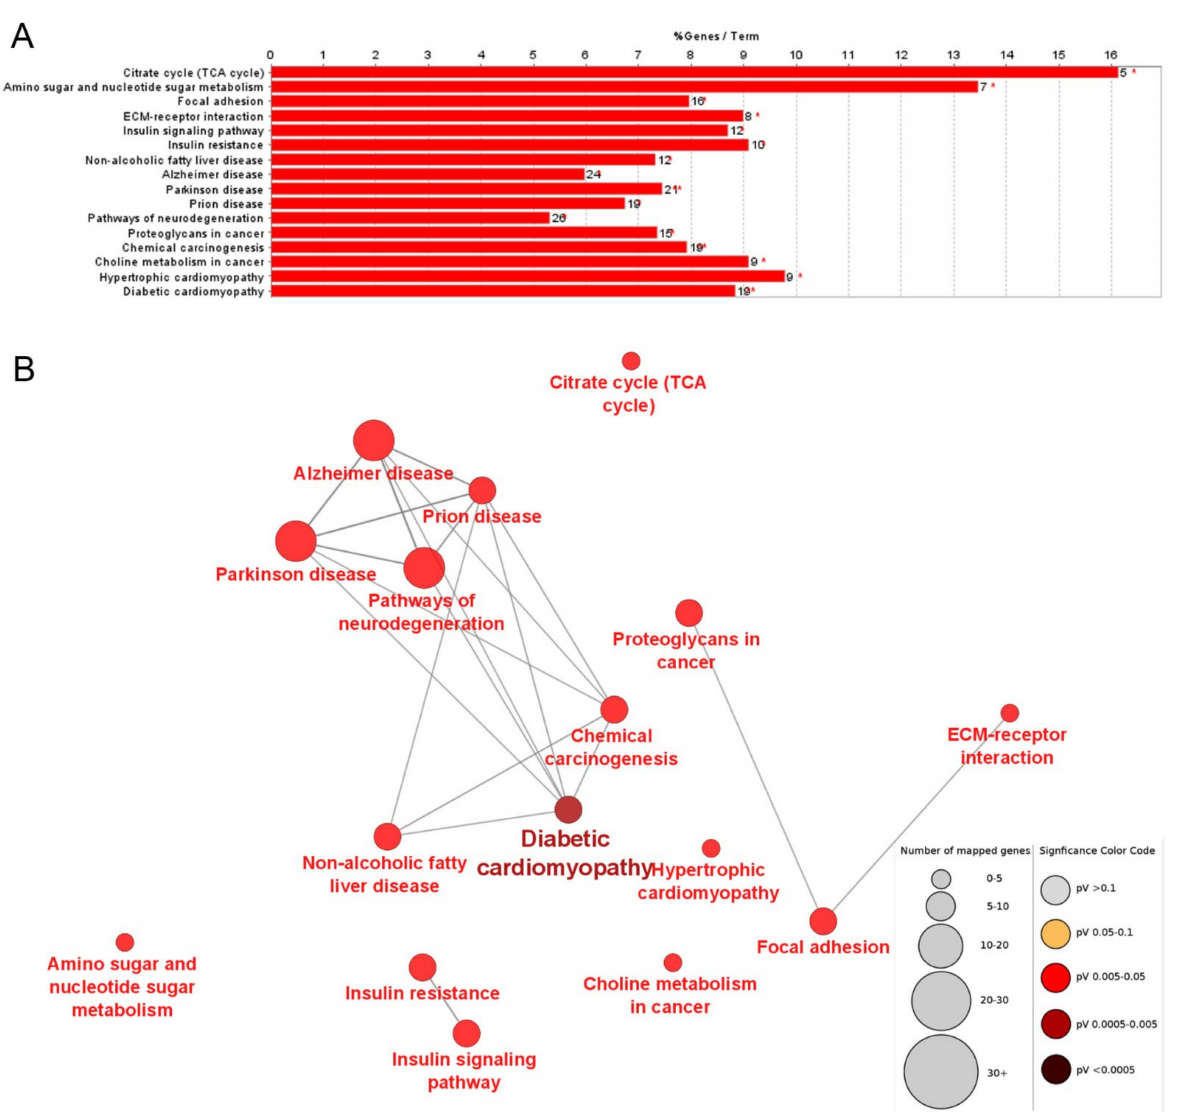
Figure 3. KEGG metabolic pathways enriched in the DASE genes. ( A ) Enrichment of KEGG biological pathways showing the number and proportion of DASE genes in the given pathways. ( B ) Interaction network of the enriched KEGG